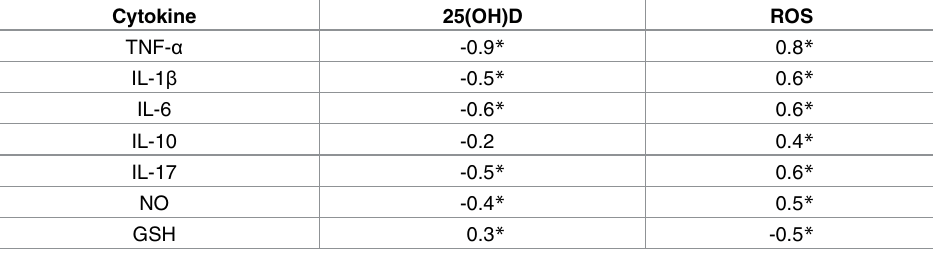
Table 2. Correlation analysis of plasma levels of cytokines with 25-hydroxy vitamin D and reactive oxygen